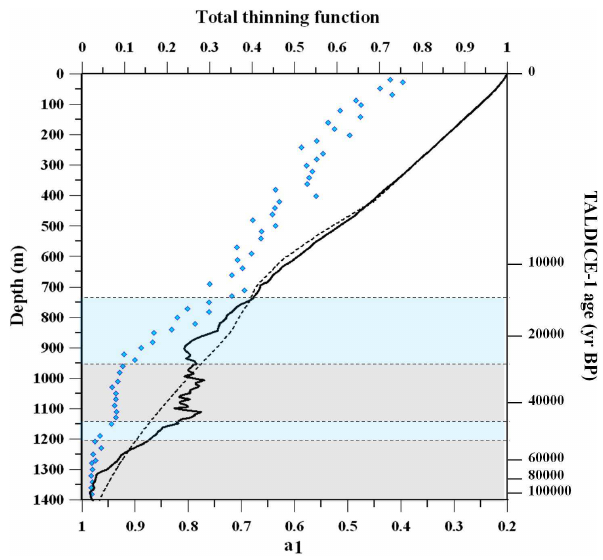
Fig. 8 : Comparison of thinning functions deduced from the a priori ice-flow model (black 1121 Fig. 8. Comparison of thinning functions deduced from the a pri- dashed line) and by the inverse model (black continuous line). They are shown together with 1122 ori ice-flow model (black dashed line) and by the inverse model the eigenvalues a 1 of the second order orientation tensor measured along the TALDICE ice 1123 core (blue diamonds). Grey and blue shades underline changes of slope in the fabric 1124 (black continuous line). They are shown together with the eigen- evolution. 1125 values a 1 of the second order orientation tensor measured along the 1126 TALDICE ice core (blue diamonds). Grey and blue shades under- line changes of slope in the fabric